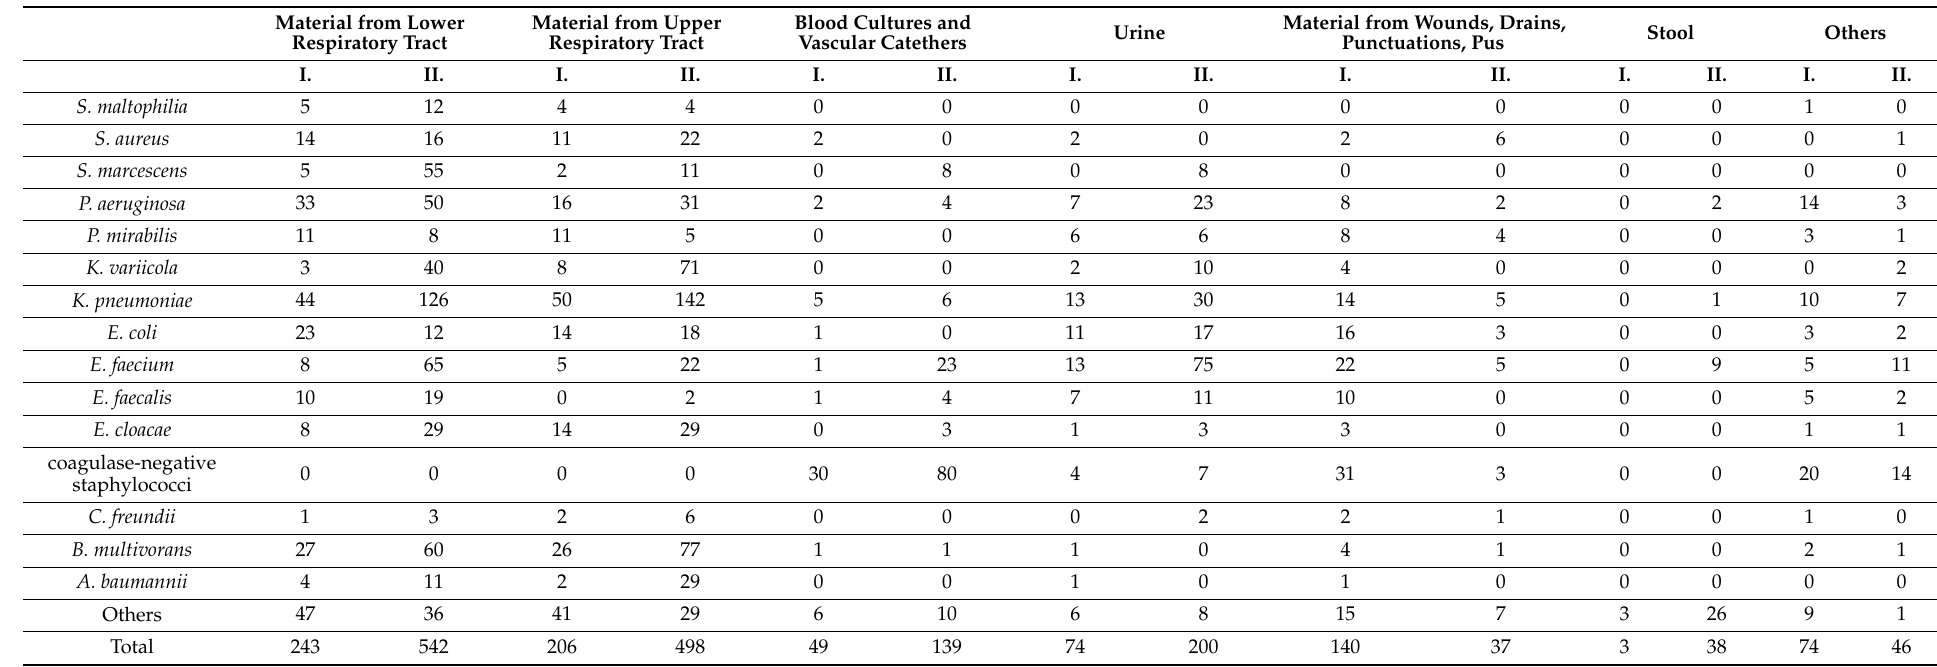
Table 2. The distribution of clinically important bacterial isolates by clinical material in both periods (absolute numbers). Material from Lower Respiratory